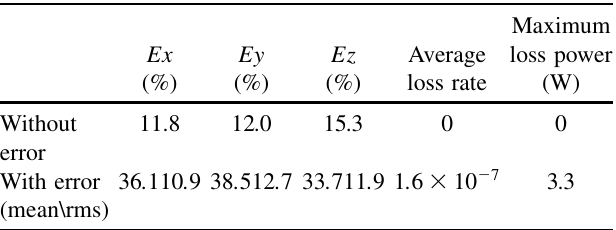
TABLE VIII. Root-mean square emittance growths and beam loss in the end-to-end simulations with and without errors.